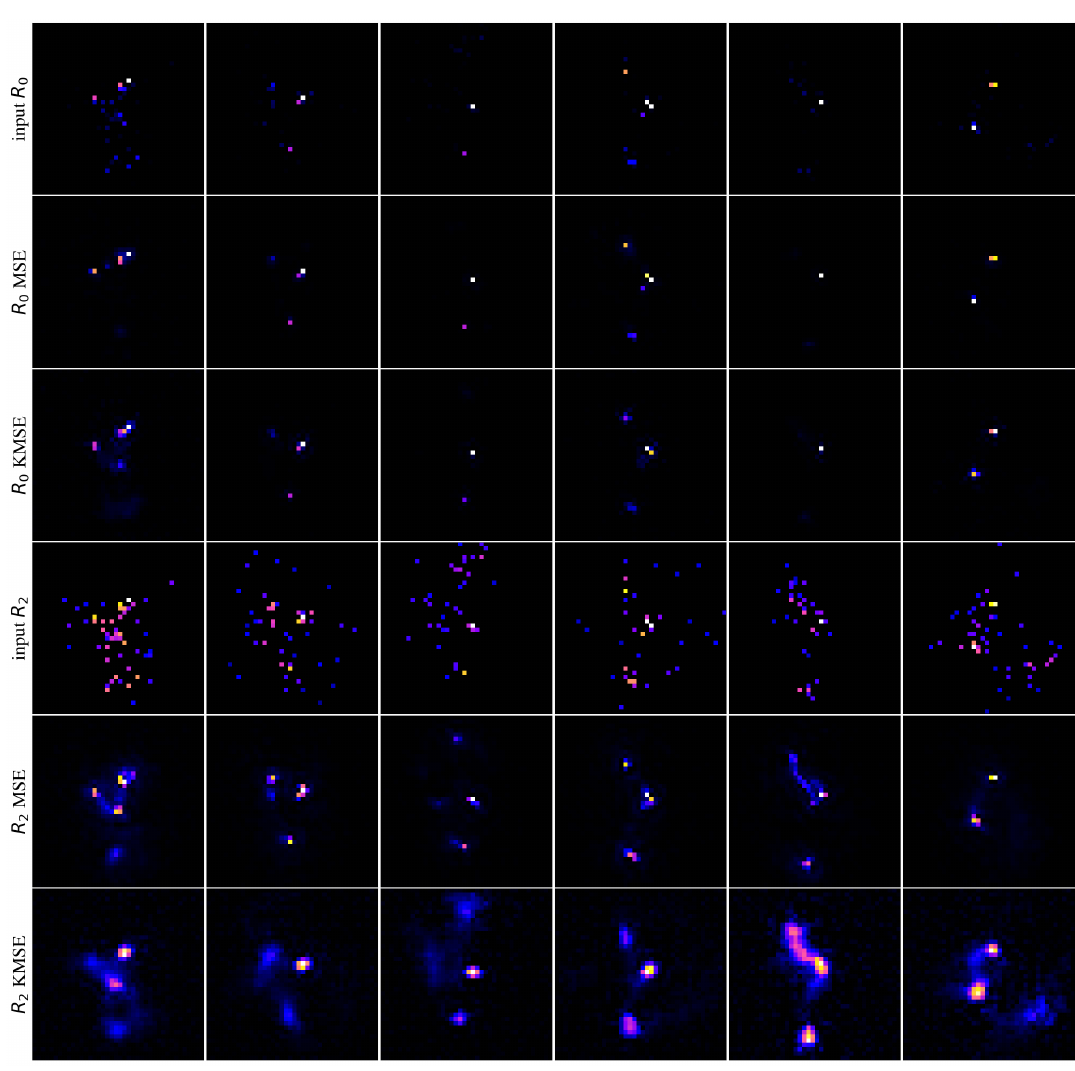
Figure 12 . Six top jet input R 0 images (first row) and the corresponding R 2 images (fourth row) together with the AE reconstructions using the MSE (second and fifth row, respectively) or KMSE loss (third and sixth row, respectively). Each image is individually normalized to have the same maximum pixel intensity. Small negative pixel intensities in the reconstructions are set to